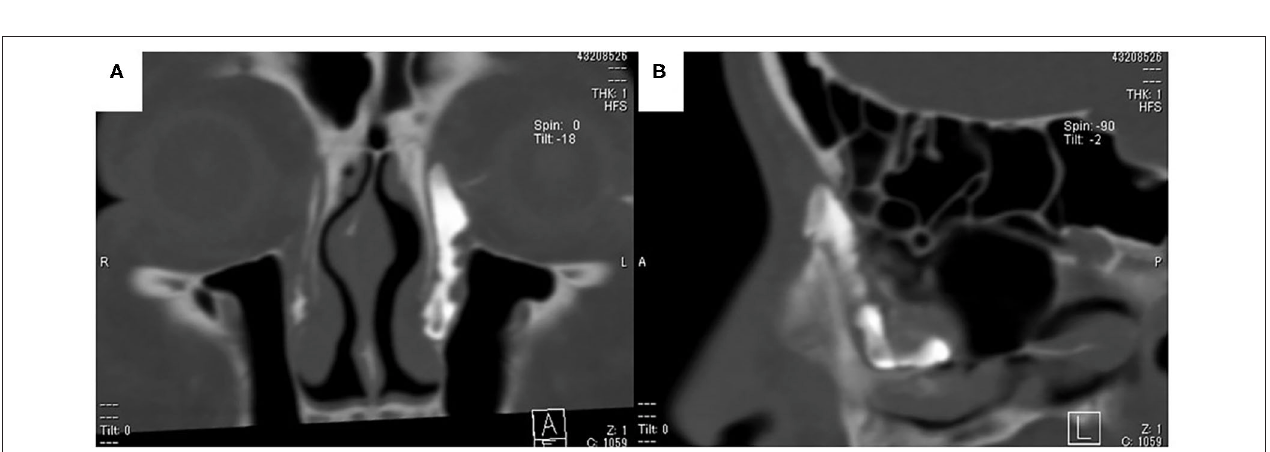
FIGURE 3 | CT-dacrocystographic findings. (A) Coronal view: contrast medium was vertically located from the lacrimal sac to the orifice. (B) Sagittal view: contrast medium accumulated posteriorly from the lacrimal